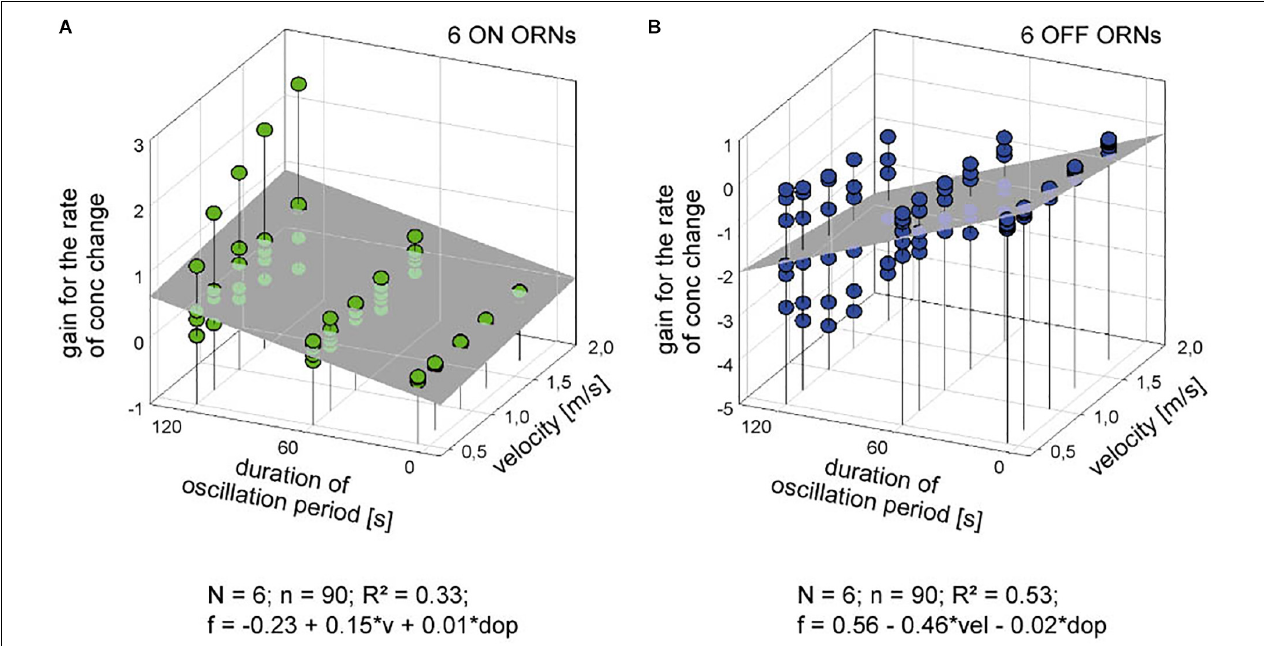
FIGURE 7 | Gain for the rate of concentration change of six pairs of ON (A) and OFF ORNs (B) plotted as a function of the oscillation period and the volume flow velocity. Multiple regressions utilizing 3-dimensional planes ( f = y 0 + a v + b dop ; where f is the gain of responses for the rate of concentration change, and y 0 the height of the regression plane) were calculated to determine the effect of velocity ( a slope) on the gain of responses for concentration oscillations with different periods ( b slope). R 2 coefficient of determination; N number of ORNs; n number of points used to calculate regression plane; dop duration of period; v